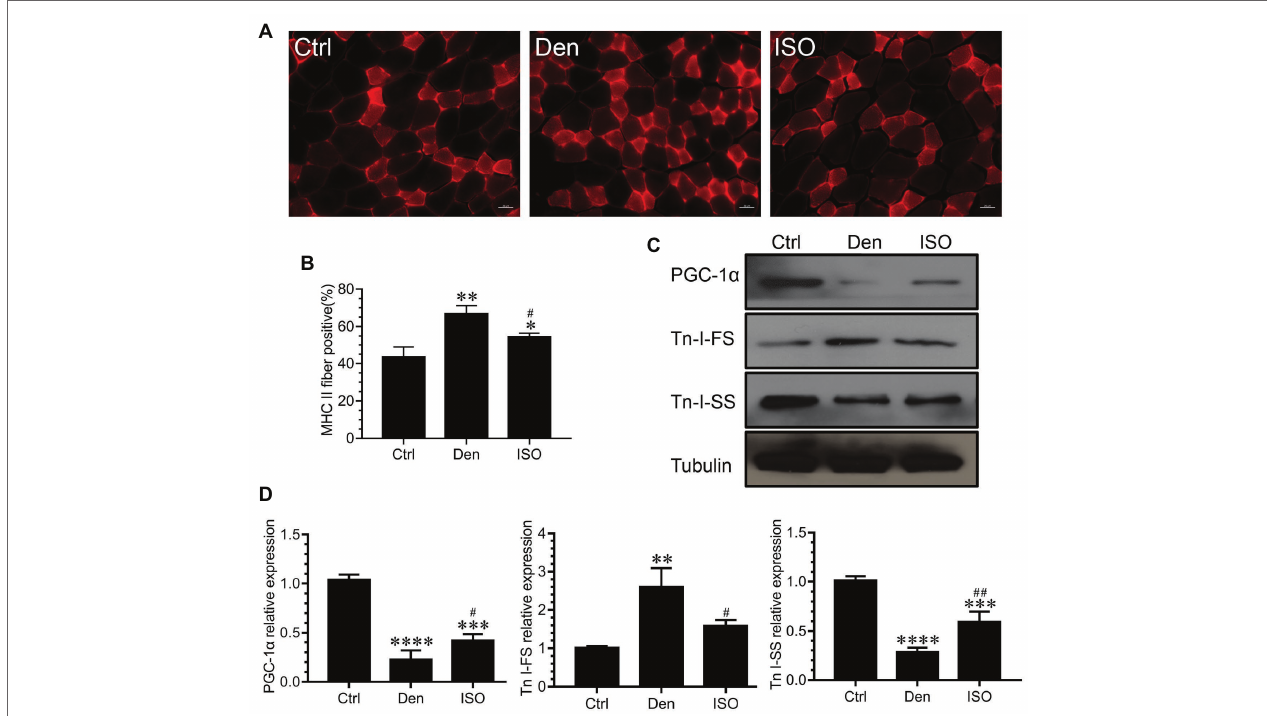
FIGURE 4 | Isoquercitrin delays the slow-to-fast fiber type conversion caused by denervation. (A) Immunofluorescence staining of fast myosin skeletal heavy chain in soleus muscle. (B) Quantification of the positive proption of fast muscle fibers ( n = 3). (C) Western blot of PGC-1 α , Tn I-FS, and Tn I-SS related to the slow-to-fast fiber type conversion. (D) Quantification of PGC-1 α , Tn I-FS, and Tn I-SS. Ctrl, control group; Den, denervation group; ISO, denervated target muscle plus isoquercitrin (20 mg/kg/d) group. * p < 0.05, ** p < 0.01, *** p < 0.001, and **** p < 0.0001 vs. Ctrl; # p < 0.05 and ## p < 0.01 vs. Den. PGC-1 α , peroxisome proliferator- activated receptor γ coactivator 1 α ; TnI-FS, fast skeletal muscle troponin I; TnI-SS, slow skeletal muscle troponin